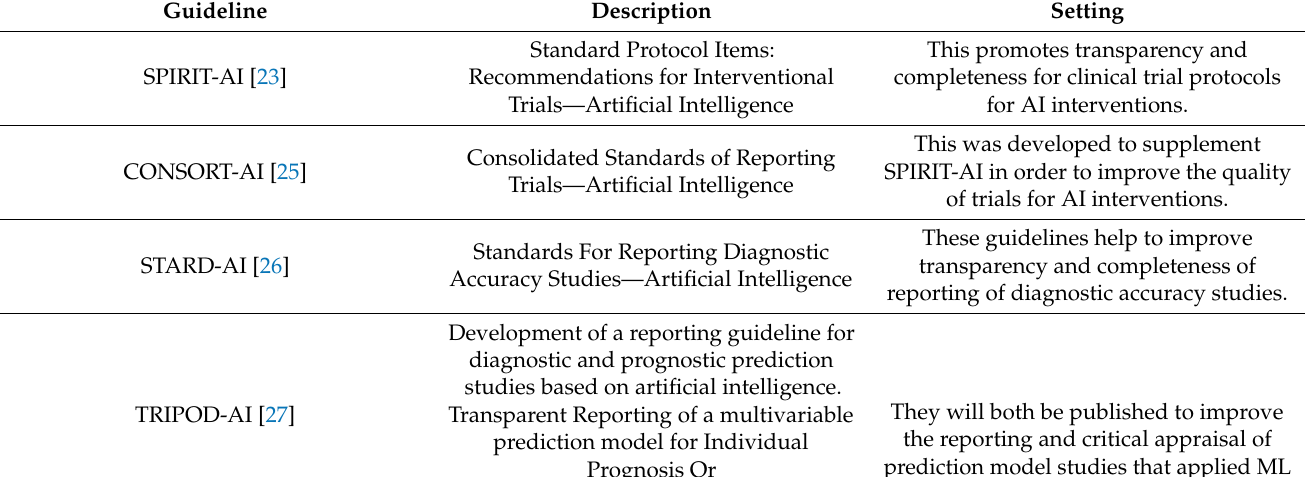
Table 2. The main guidelines regarding the use of AI in clinical